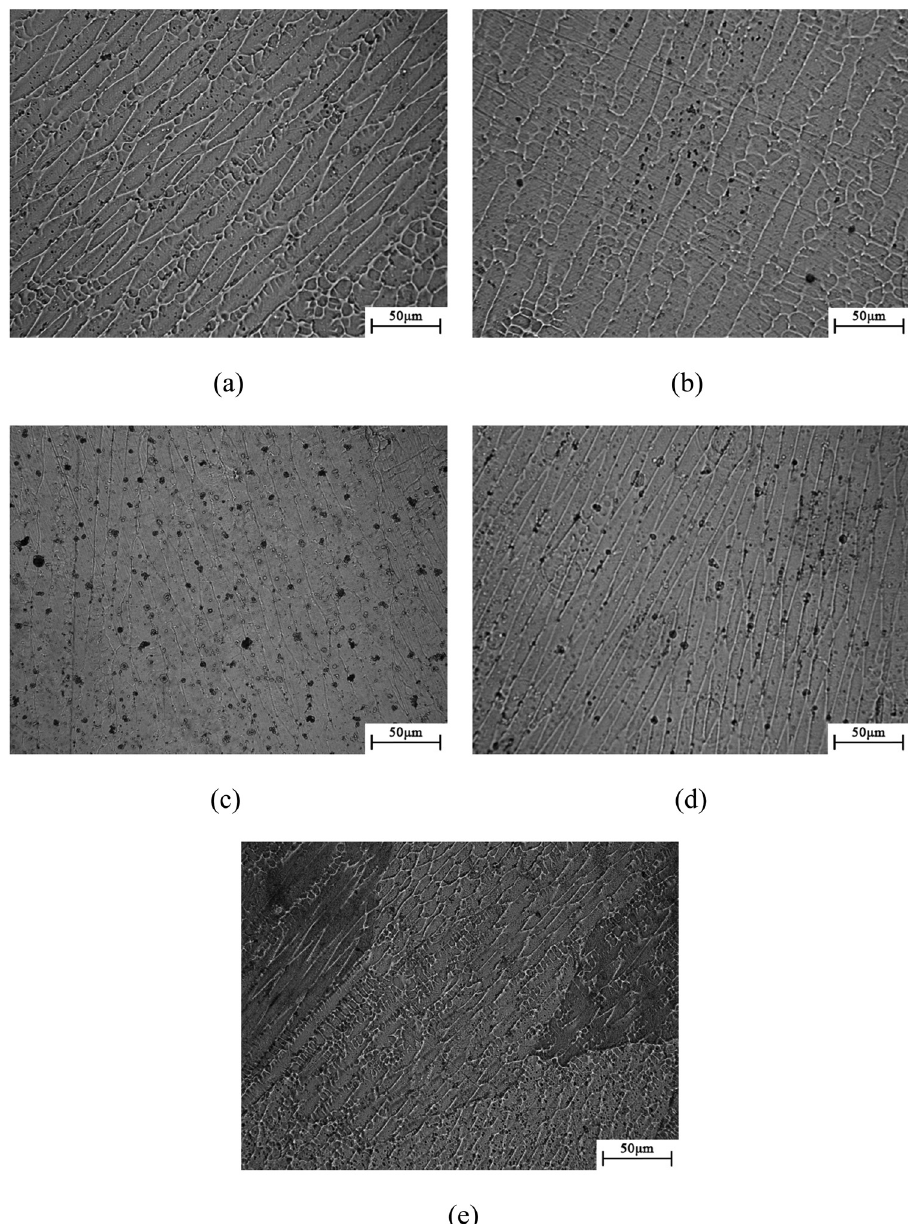
Figure 13: Dendritic morphology of material obtained at di ff erent scan speeds V s : ( a ) 4 mm · s − 1 ; ( b ) 7 mm · s − 1 ; ( c ) 10 mm · s − 1 ; ( d ) 13 mm · s − 1 ; and ( e ) 16 mm · s − 1